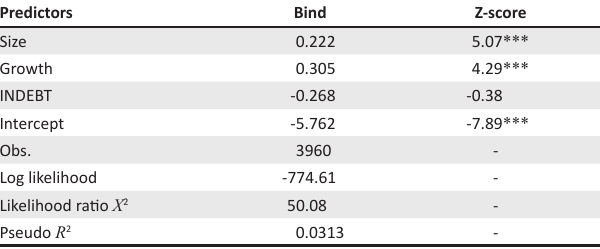
TABLE 2: Estimation of propensity score function and Logit